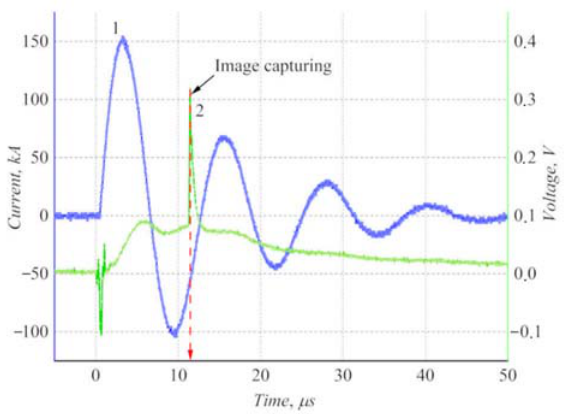
Figure 5. Typical current waveform (1) and photodiode signal (2). The peak corresponded to image capturing .